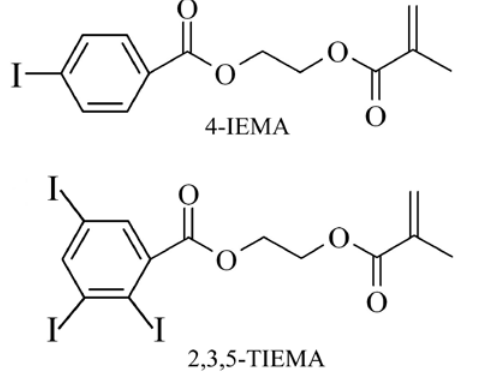
Figure 2. Chemical structure of the iodine containing methacrylic monomers 2-[4’- iodobenzoyloxy]ethyl methacrylate (top) and